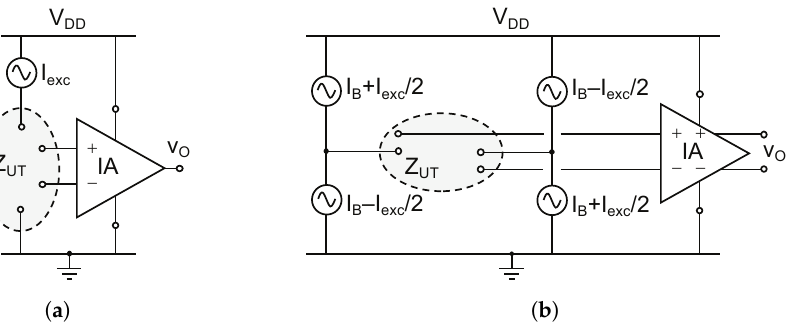
Figure 1. Conceptual scheme of a bioimpedance measurement system: ( a ) single-output and ( b ) differential-output